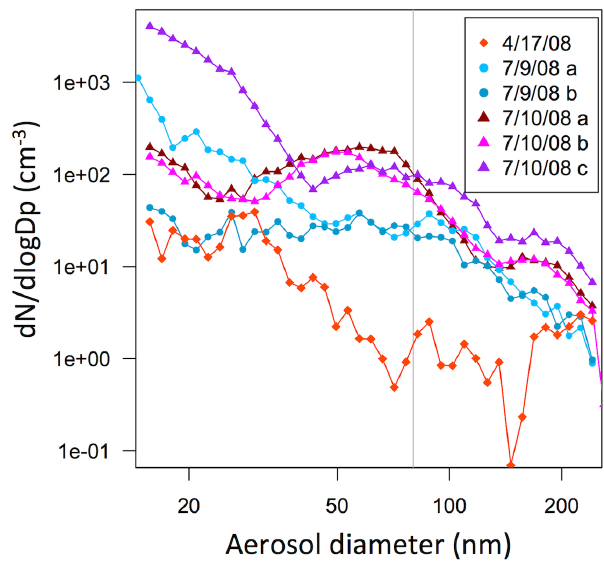
Figure A1. Mean out-of-cloud aerosol particle size distributions for several ARCTAS background aerosol events. Some days had multi- ple background aerosol events; these are distinguished by color and the letters (a) – (c) . The light gray line shows the 80nm cutoff used here to distinguish Aitken-mode particles from accumulation-mode